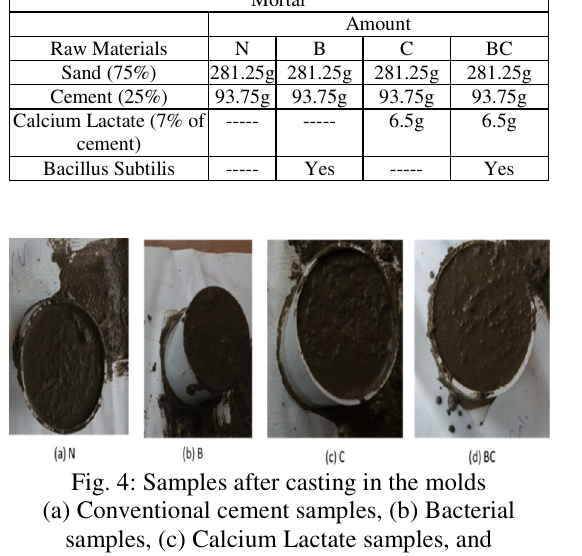
Fig. 4: Samples after casting in the molds